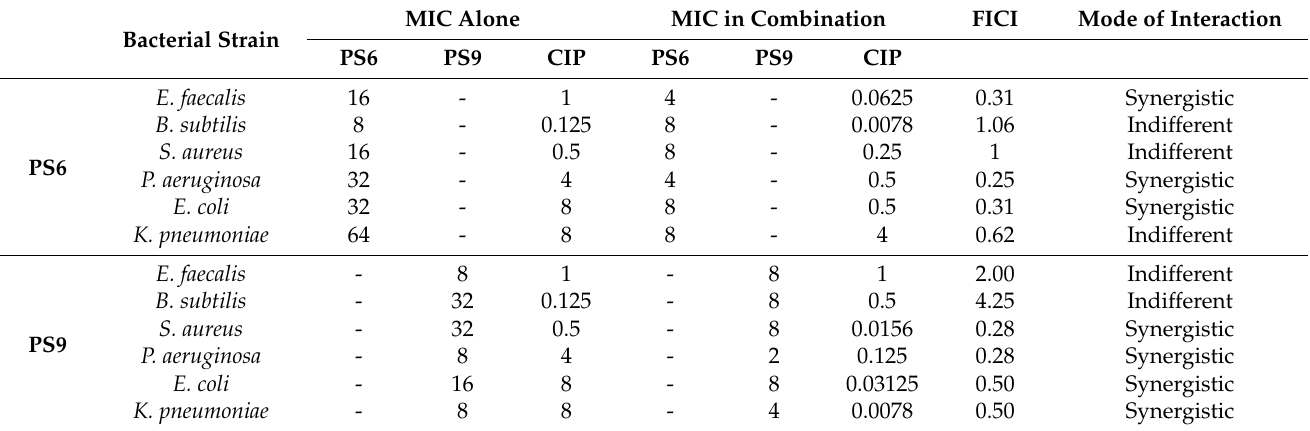
Table 6. Combination study of PS6 and PS9 with CIP ( µ g/mL).